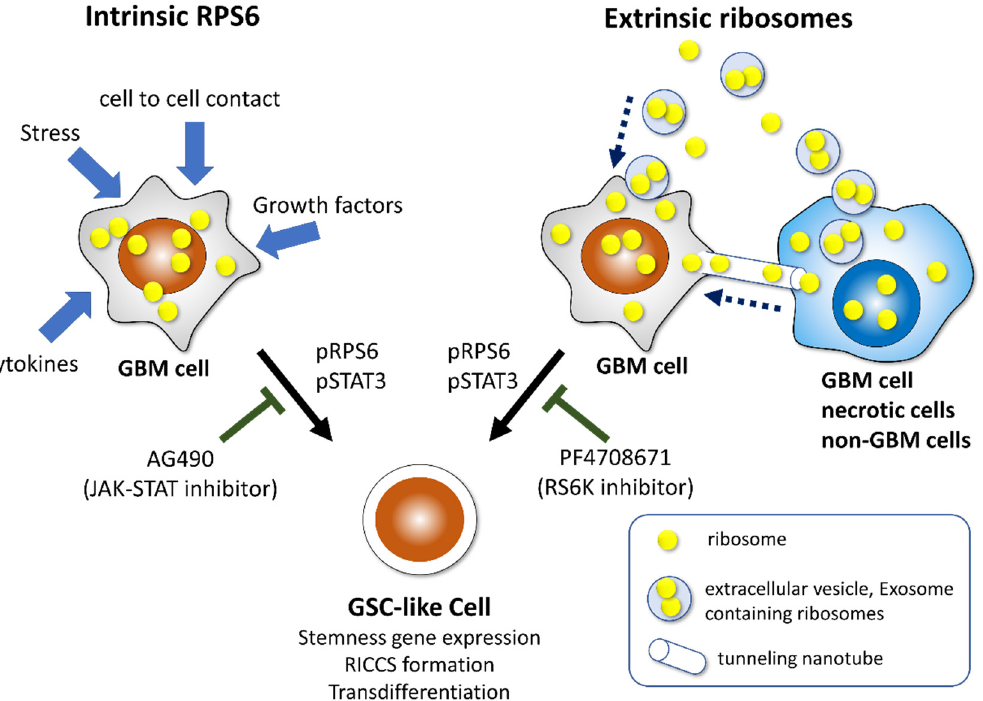
Figure 6. Intrinsic RPS6 and extrinsic ribosomes induce GSC-like phenotypes in GBM cells. Multiple stimuli in the tumor microenvironment induce ribosome biogenesis. The overexpression of RPS6 increases stemness gene expression and RICCS formation, which is suppressed by AG490 (JAK-STAT inhibitor). GBM cells communicate with other GBM cells, necrotic cells, and non-GBM cells through extracellular vesicles, including exosomes and tumor nanotubes. Ribosome incorporation promotes stemness gene expression and RICCS formation, which is suppressed by PF4708671 (RPS6K inhibitor). Cells in RICCS acquire transdifferentiation potentials.